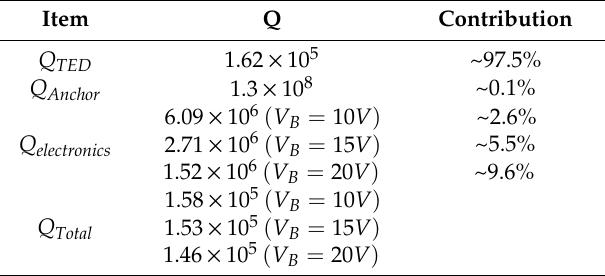
Table 4. Calculated Q of the